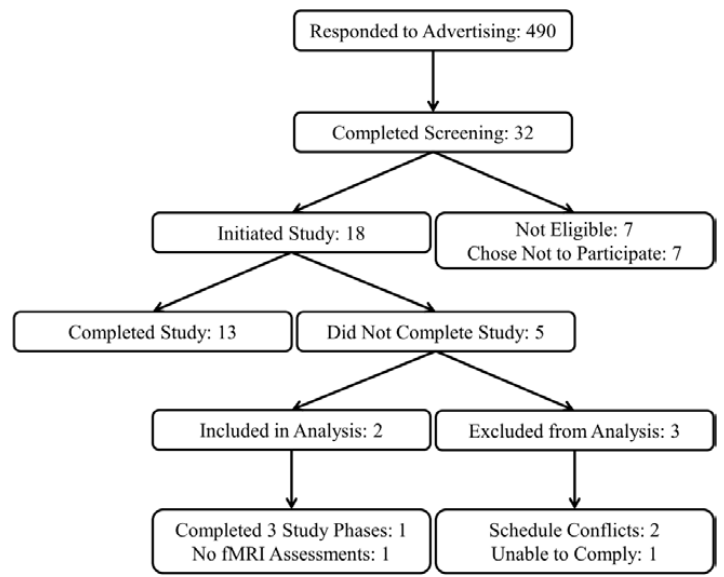
Figure 1. Study recruitment flow diagram.